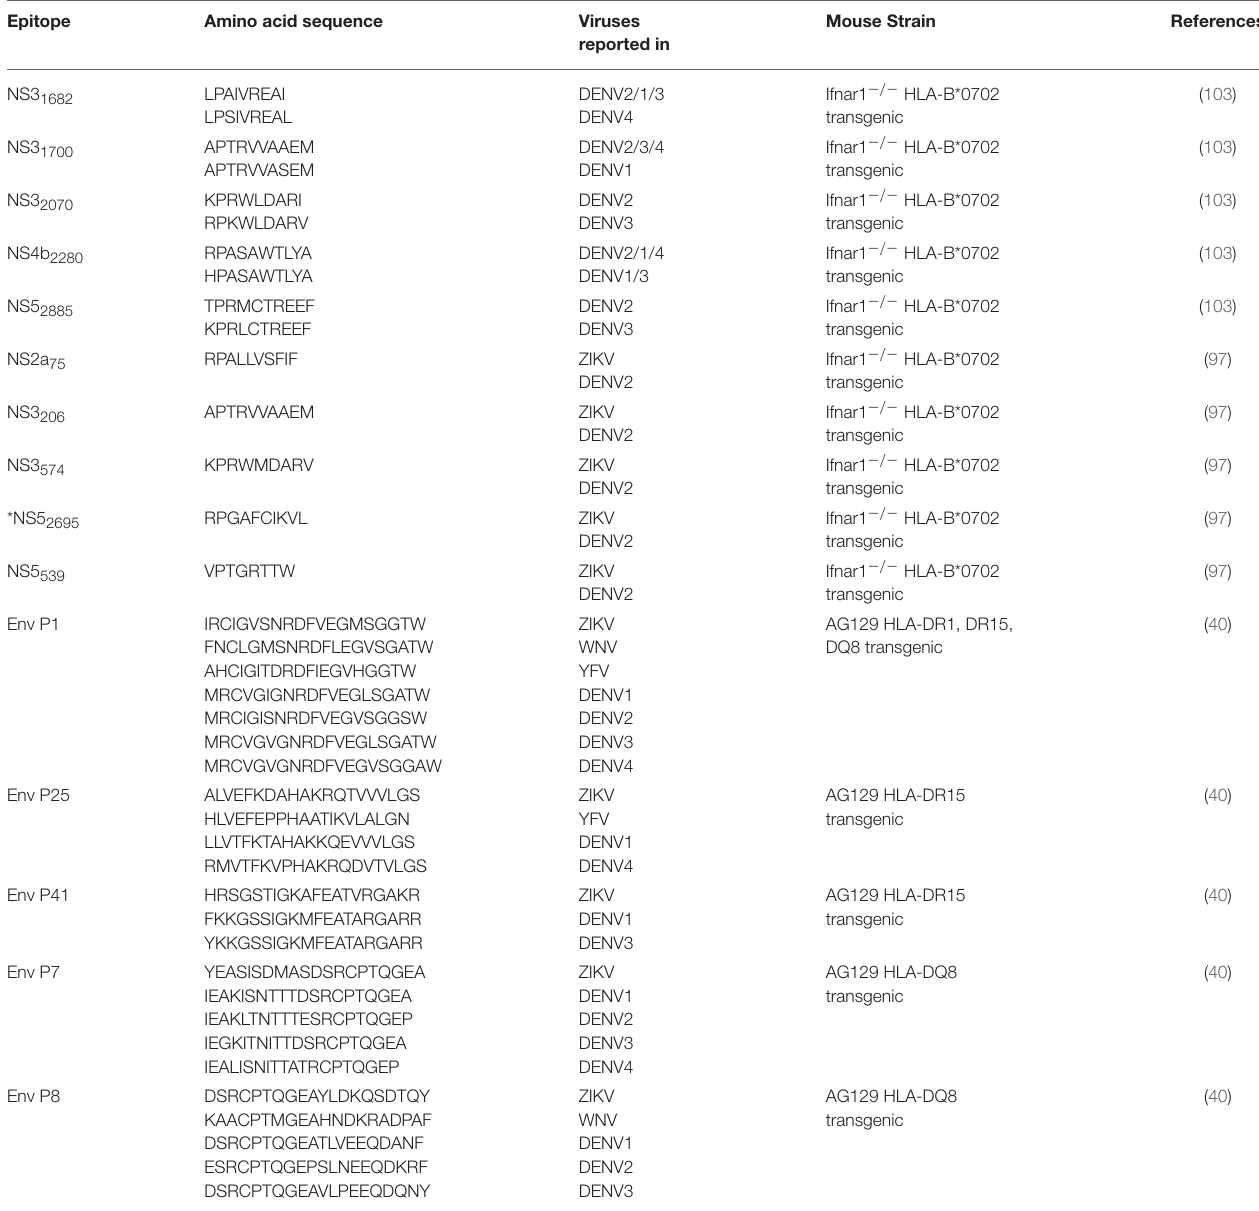
TABLE 3 | Flavivirus cross-reactive T cell epitopes identified using HLA transgenic murine models, named in the same manner as the papers they were identified in with the exception of (*)NS5 2695